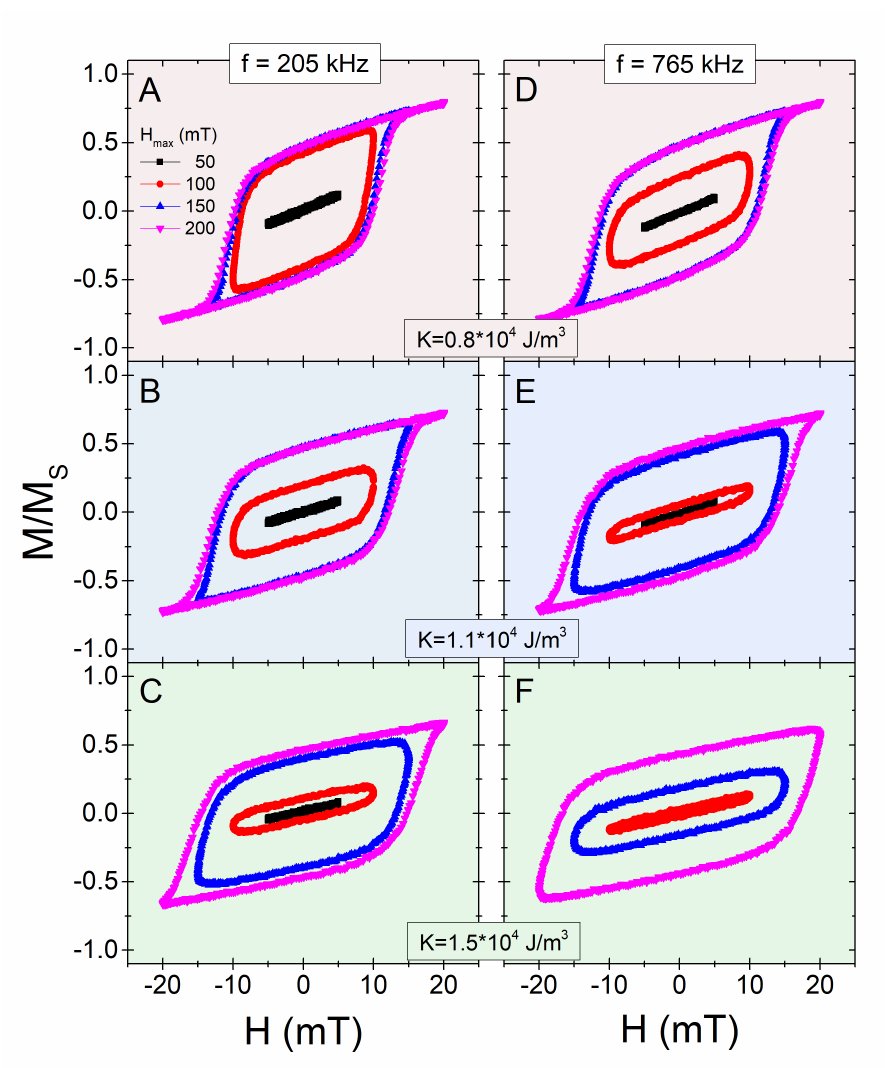
Figure 4. M ( H ) hysteresis loops, for different H max values, as indicated by the labels in panel ( A ). Left and right columns correspond to f = 205 and 765 kHz, respectively. Each pair of colour panels ( A , D ), ( B , E ), and ( C , F ), corresponds to a different K value (indicated within the figure) and its corresponding d aggl (Table